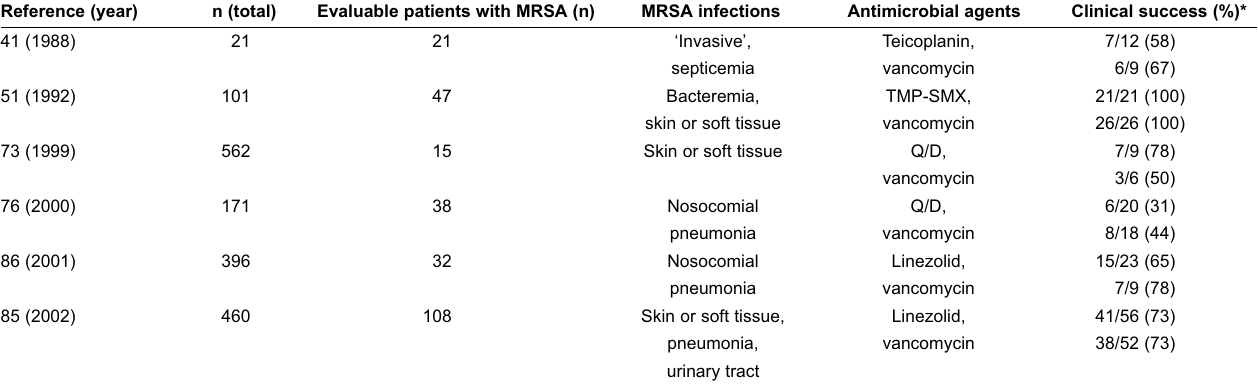
TABLE 1 Randomized, controlled trials of antimicrobial agents for the treatment of infections caused by methicillin-resistant Staphylococcus aureus